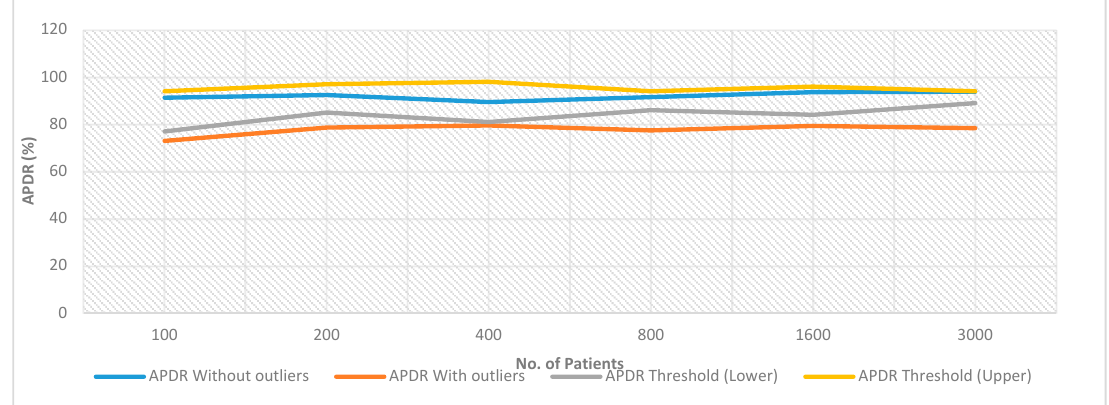
Figure 40. Average Packet Data Rate (ADPR) for Proposed IoT-Sensor based Network.